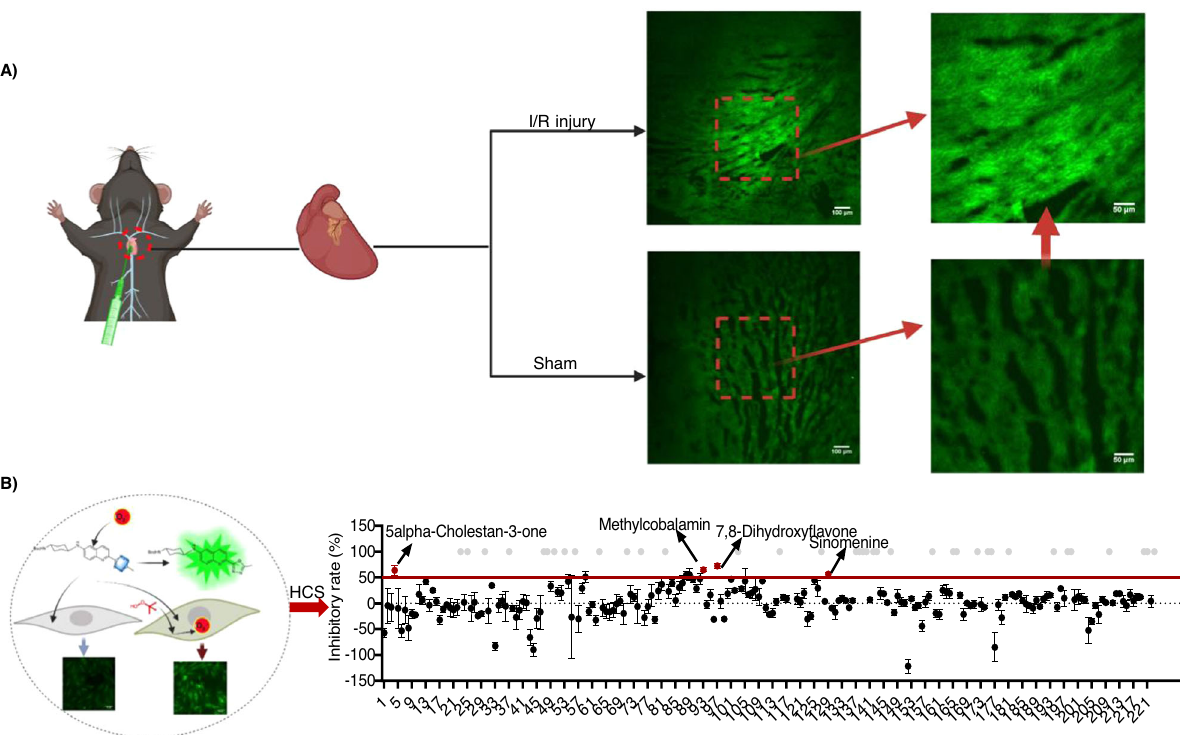
Fig. 5 | High-content screening for superoxide modulators from natural pro- ductsbyF-Tz4staining.A Exvivo F-Tz4 imagingofsuperoxideproductionduring myocardial I/R injury. n =4 mice. B The illustration of cell imaging schematic and